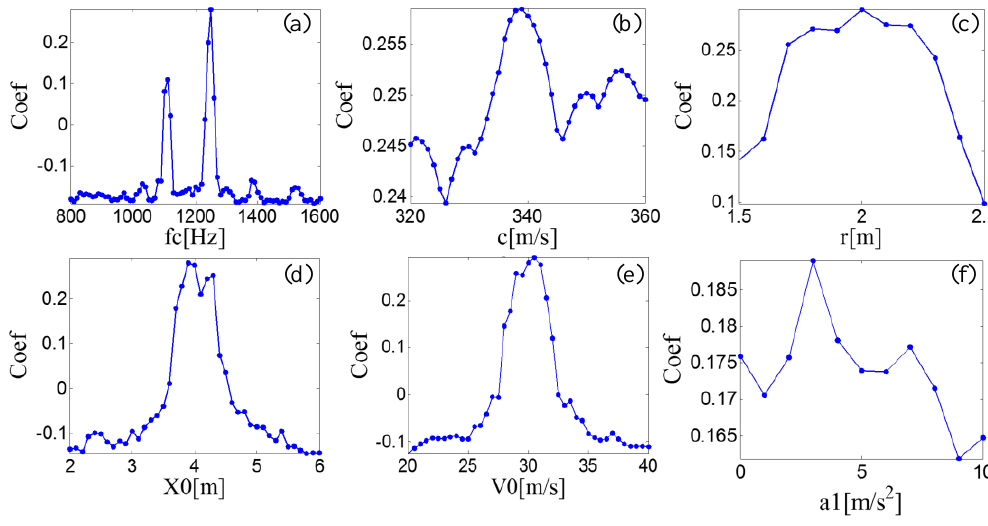
Figure 18. Maximal correlation coefficients for the different elements from a specified PMDW model parameter subset for the Doppler-shifted signal with the out-race defect.